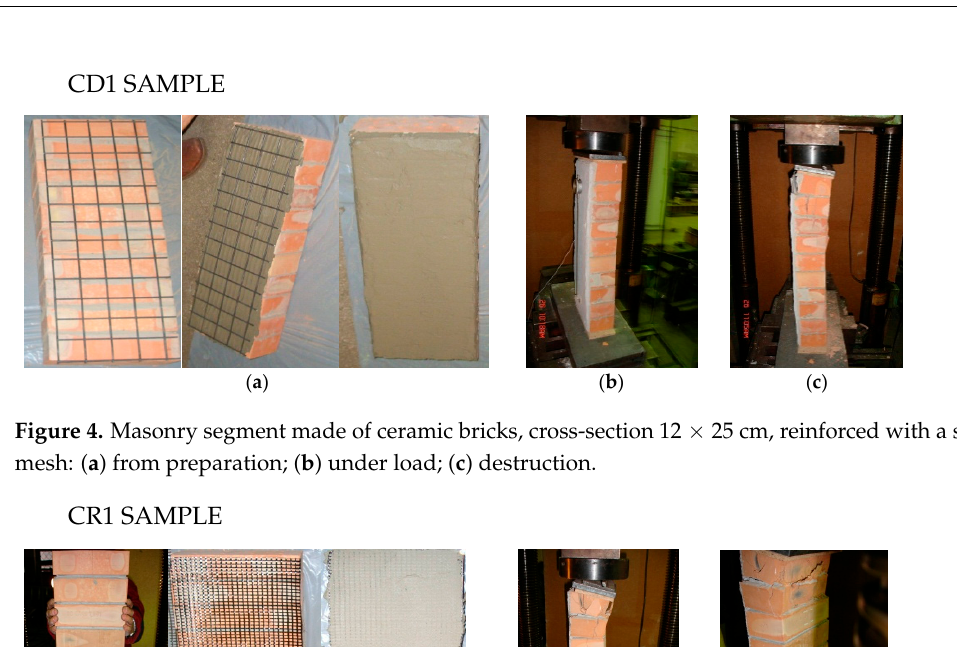
Figure 3. Ceramic brick wall segment without reinforcement, cross-section 12 × 25 cm: ( a ) from preparation; ( b ) under load; ( c ) destruction.